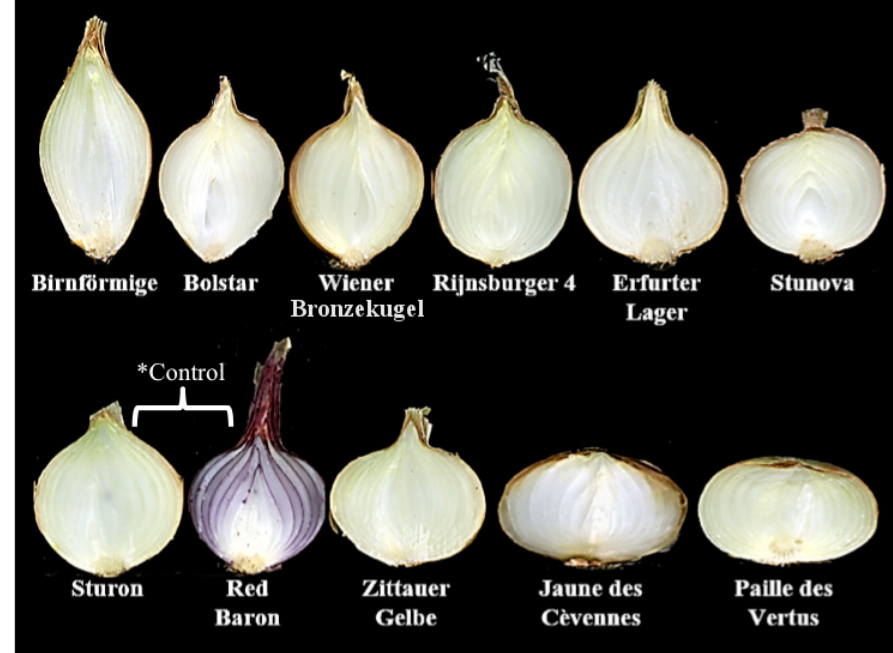
Fig. 1: Longitudinal section of open-pollinated onion varieties used in the field trial.